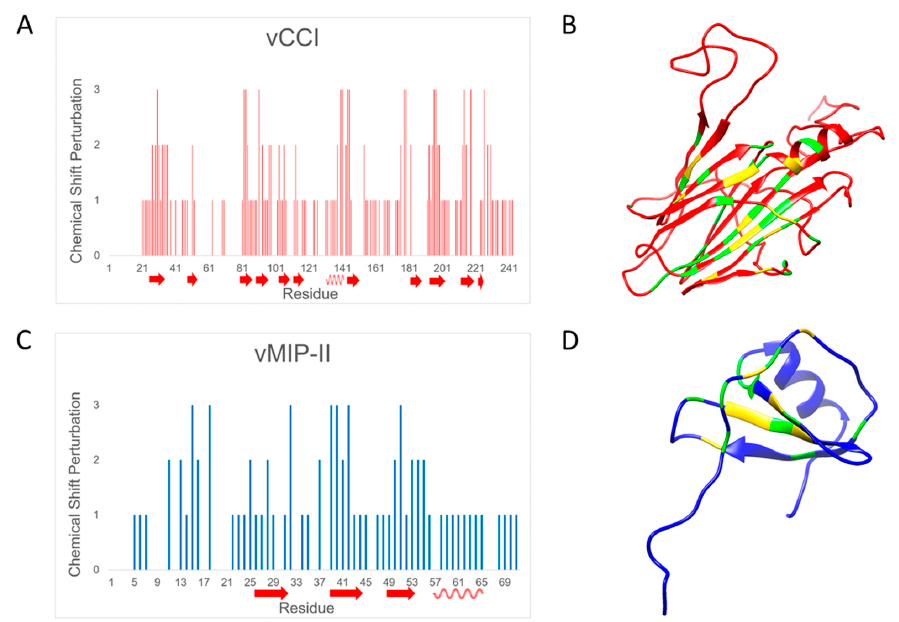
Figure 3. Changes in chemical shift upon complex formation. ( A ) Changes in chemical shift in vCCI upon binding to vMIP-II. Arrows represent beta strands while spiral lines represent alpha helices. See Table 1 for definitions of “0”, “1”, “2”, “3”; ( B ) Structure showing changes in vCCI (Protein Data Bank code 2FFK upon binding vMIP-II. Green indicates greater than average, up to 1 standard deviation away from the average; yellow indicates over 1 standard deviation away from the average; red indicates below one standard deviation or the peak had not been discernable; ( C ) Changes in chemical shift in vMIP-II upon binding to vCCI. Secondary structure is shown by arrows and spiral lines, as in (A). See Table 1 for definitions of “0”, “1”, “2”, “3”; ( D ) Structure showing those changes in vMIP-II upon binding vCCI (Protein Data Bank code 1VMP). Green indicates greater than average, up to 1 standard deviation away from the average; yellow indicates over 1 standard deviation away from the average; blue indicates below one standard deviation or the peak had not been discernable. All